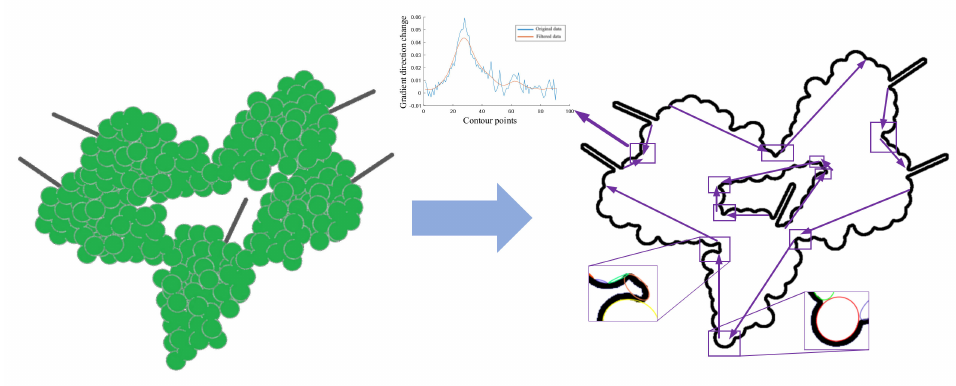
Figure 6. Segmentation point constraints of the cluster region.